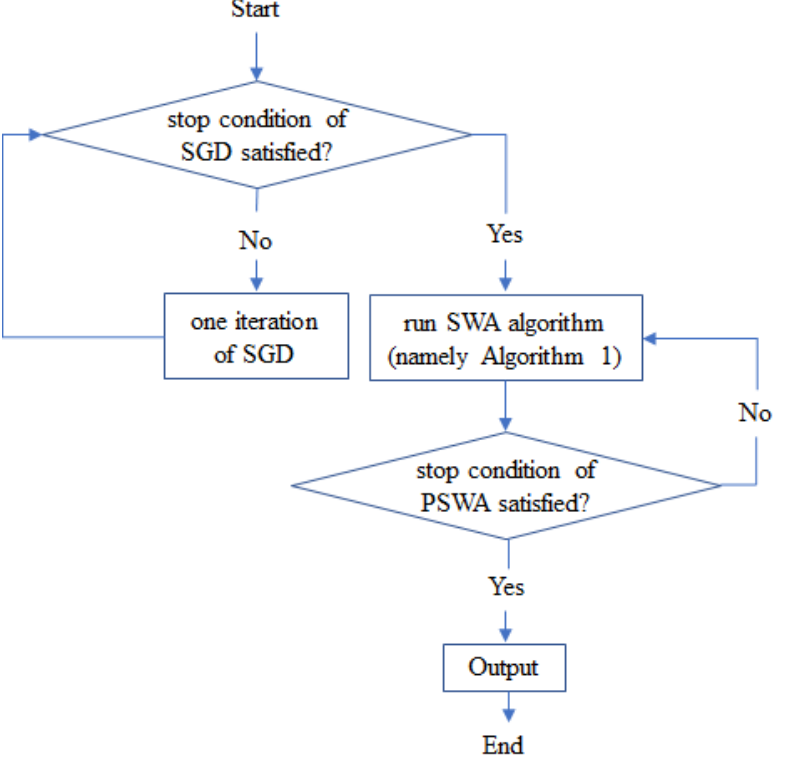
Figure 3. Block schema of PSWA. PSWA consisted of a backbone SGD that processed before the SWA operations and a series of SWA procedures that processed sequentially. The first SWA procedure was initialized by the output of the backbone SGD. For each of the other SWA procedures, its starting weight seed was the output of its previous SWA procedure. In contrast to the original SWA method, which was invoked when its preceding SGD converged, the PSWA was initialized when its preceding SGD was in an early stage of its